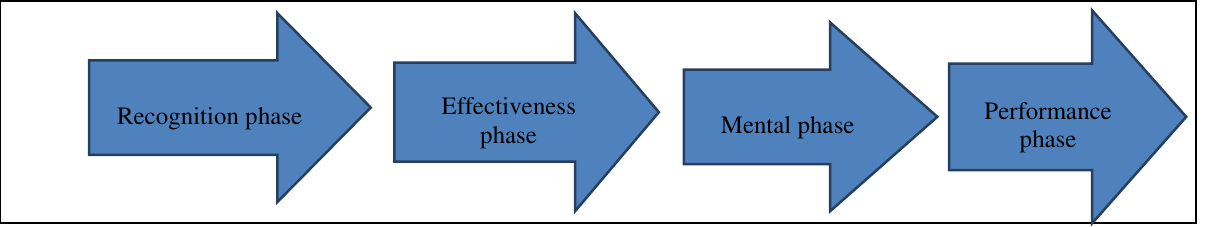
Fig. 3. The levels of increasing